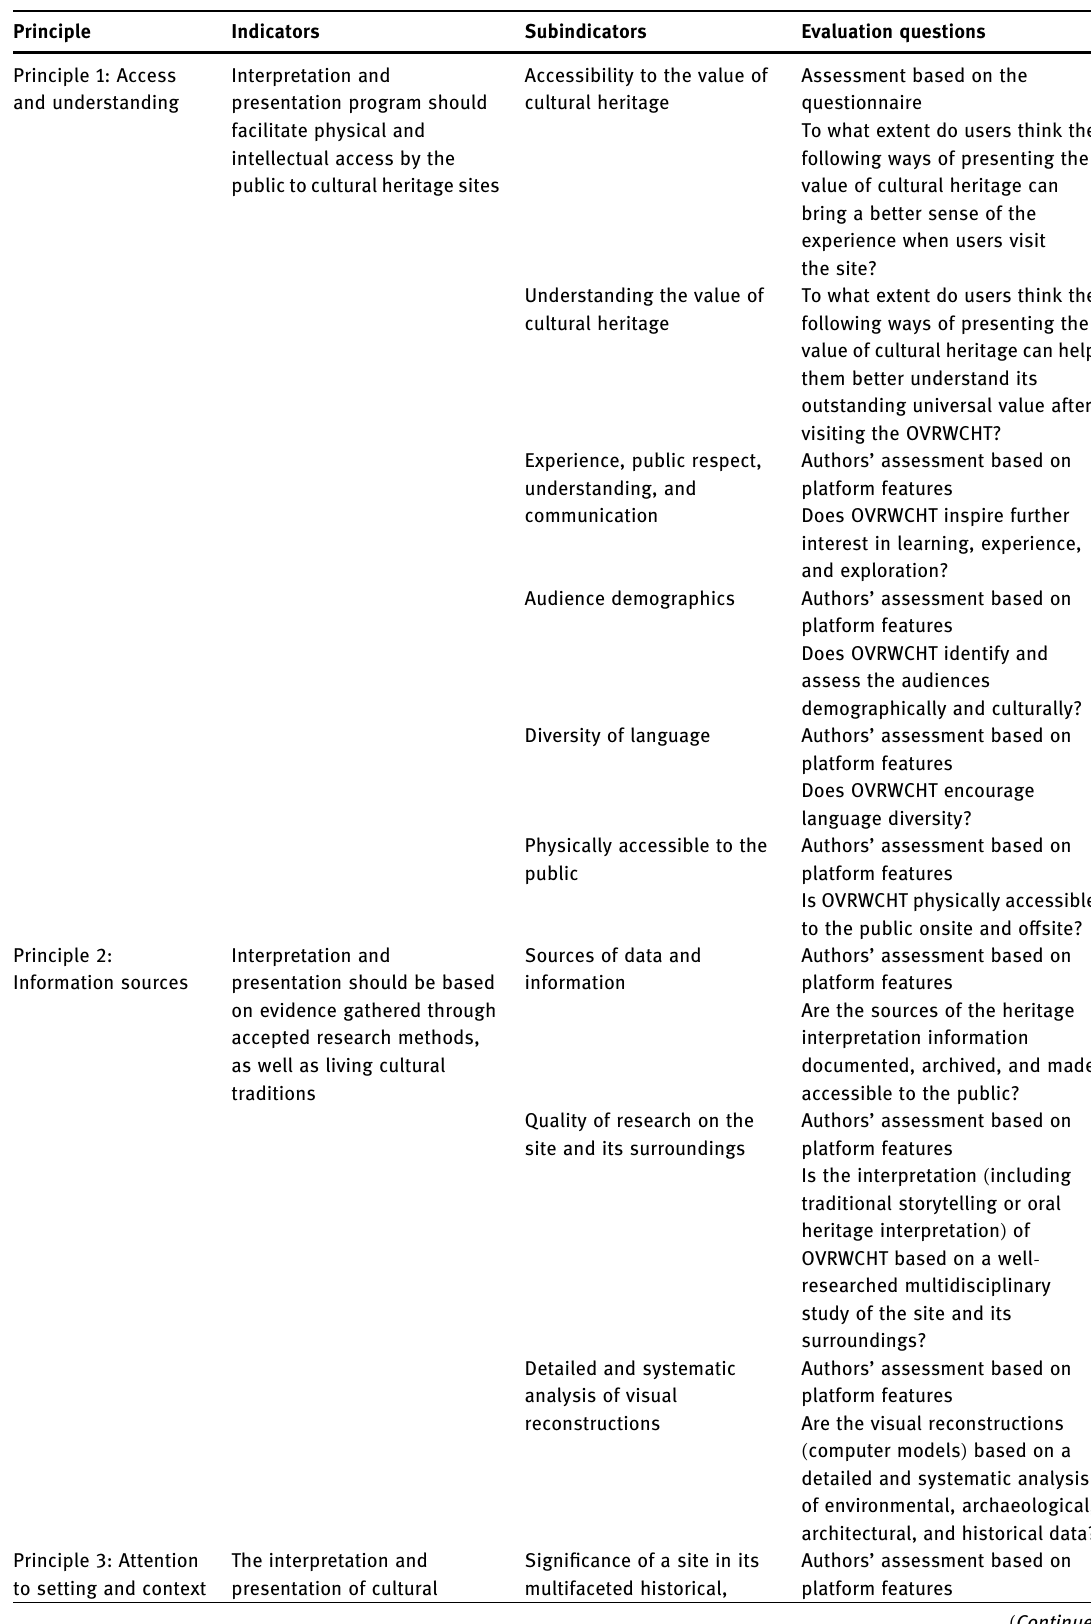
Table 1: Assessment framework based on the Charter for the Interpretation and Presentation of Cultural Heritage Sites